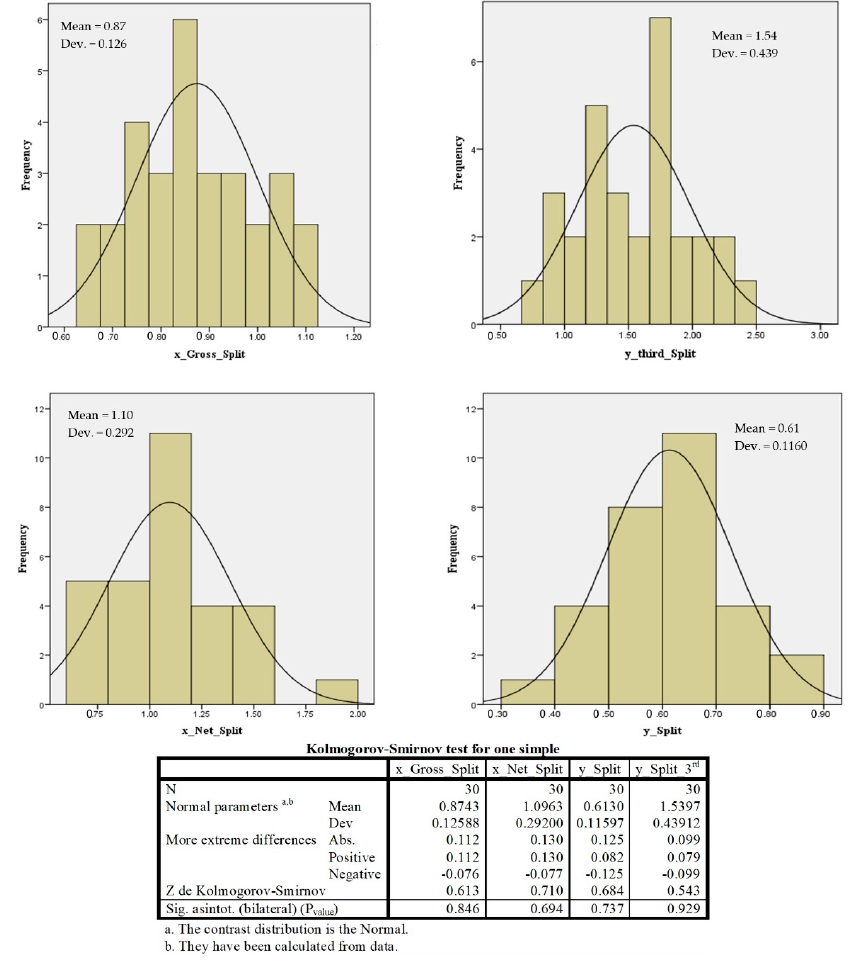
Figure 6. Normality tests for the experimental results.